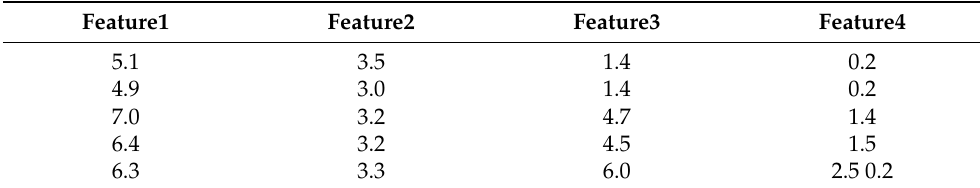
Table 1. Raw tabular data example extracted from iris plant dataset [28].